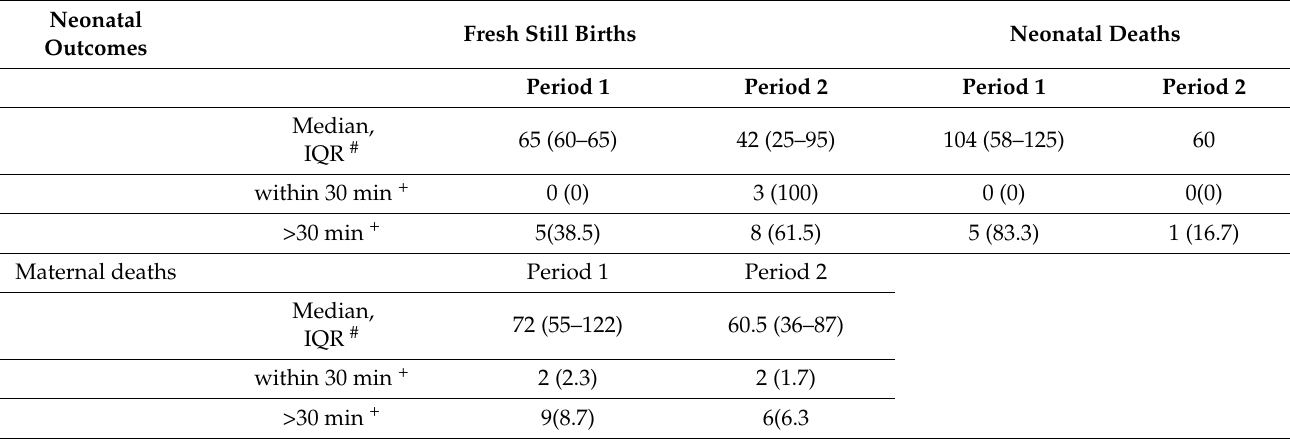
Table 4. Decision to incision time and selected maternal and neonatal